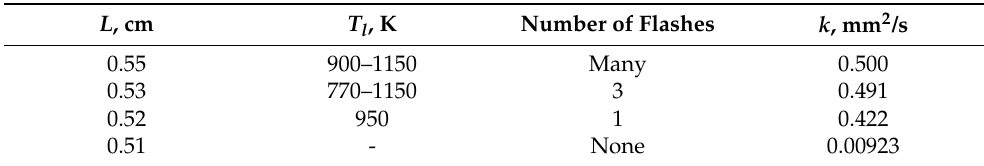
Table 2. The effect of L on the burning/evaporation rate constant of the n-dodecane droplet at NPT conditions. L , cm T l ,